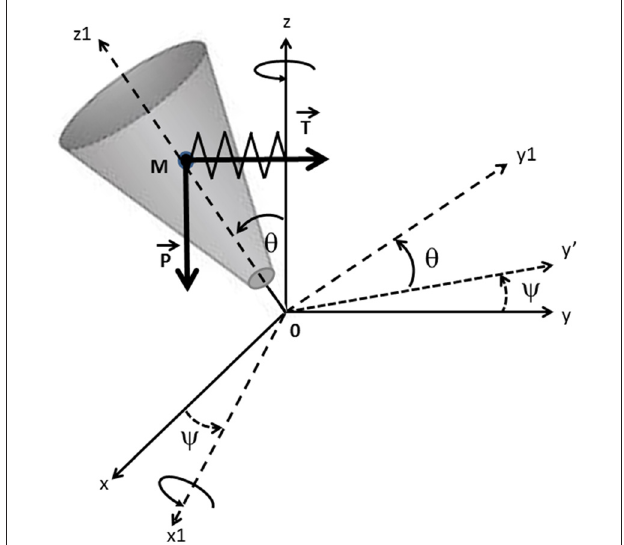
FIGURE 2 | Mechanical model. The mechanical model is represented as a conic inverted pendulum which pivots about a fixed point 0. Body displacement during the swing phase (from toe off to foot contact) presents five degrees of freedom on the absolute referential (0; x ; y ; z ). (0; x 1 ; y 1 ; z 1 ) are the main axes of the inertia momentum of the solid body after precession ψ around z and nutation θ around x 1 . The center of mass m falls under the influence of the gravity force P and the elastic restoring force T . The initial position and velocity of the cone correspond to the position and velocity of the subject’s center of mass at toe